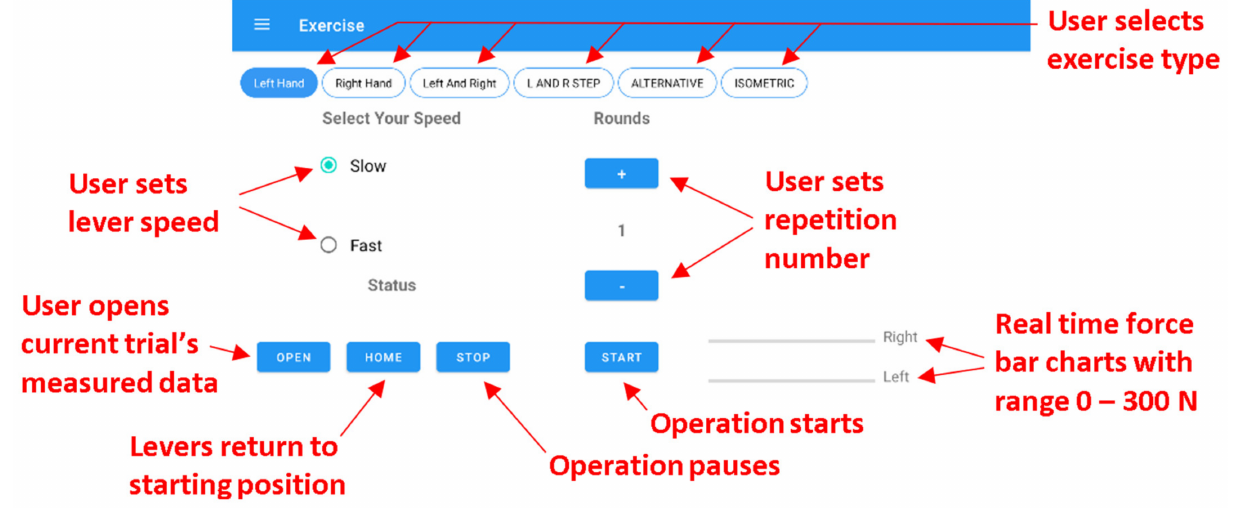
Figure 11. Control panel tab on the FIT-WHEEL